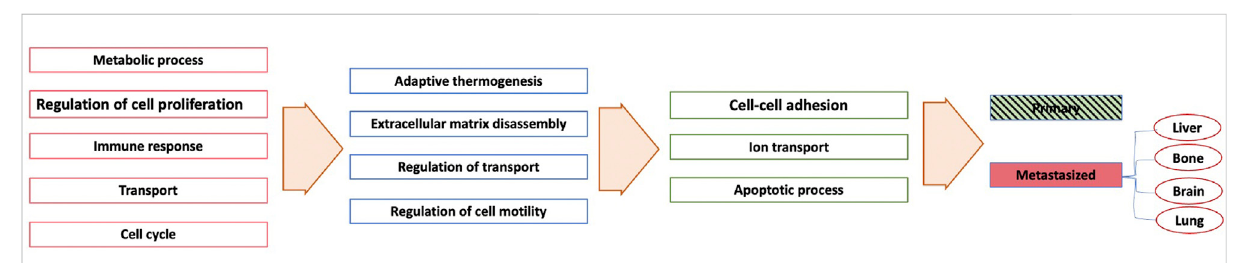
FIGURE 8 The biological interpretation of our deep neural network approach.